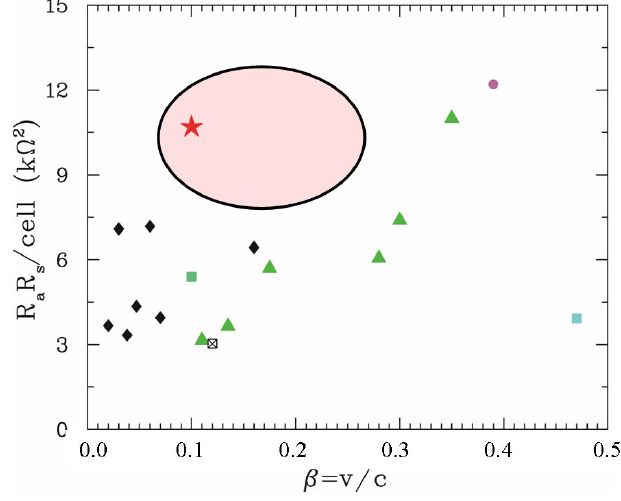
FIG. 46. (Color) R in Fig. 45.FIG. 45. (Color) R